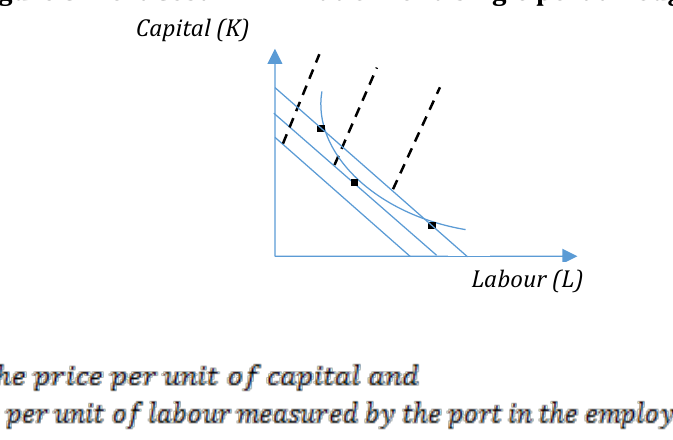
Figure 3: Port Cost minimization for a single port